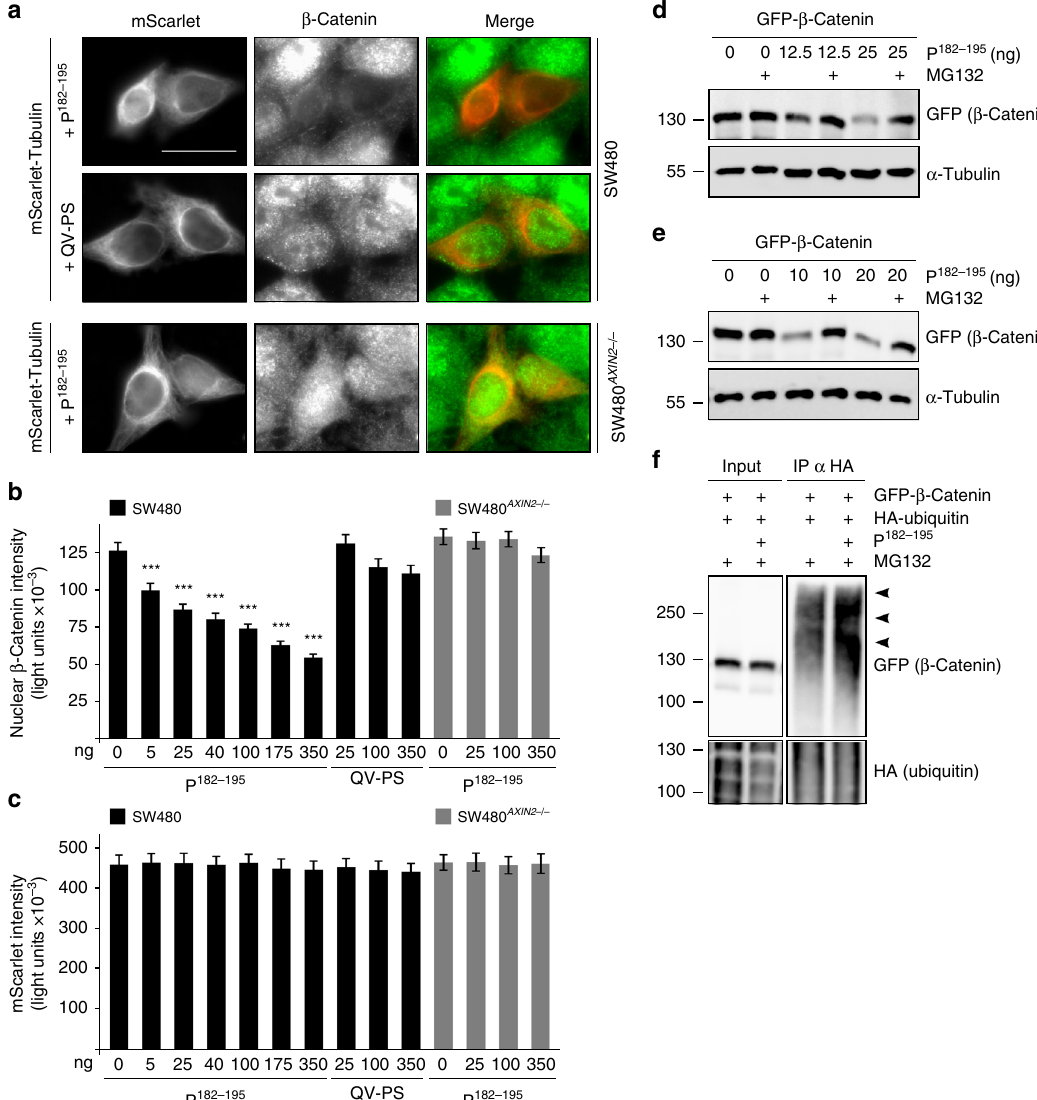
Fig. 6 P 182 – 195 induces proteasomal degradation of β -catenin. a Immuno fl uorescence staining of endogenous β -catenin (green) in SW480 and SW480 AXIN2 knockout cells co-transfected with P 182 – 195 or its QV-PS mutated analog together with mScarlet-tubulin (red) to visualize transfected cells. Scale bar: 20 µ m. b , c Quanti fi cation of nuclear β -catenin ( b ) or mScarlet ( c ) fl uorescence intensities in individual cells of four independent experiments as in a . Results are mean ± SEM ( n = 80); *** p < 0.001 (Student ’ s t -test). Da t a distribution is shown in Supplementary Fig. 10. d , e Western blotting for GFP and α -tubulin (loading control) in lysates of DLD1 ( d ) or HEK293T cells ( e ) transfected with indicated constructs, which were untreated or treated with the proteasome inhibitor MG132 (DLD1: 10 µ M for 6 h; HEK293T: 2.5 µ M for 2 h). Given nanograms (ng) of the peptide refer to the transfection of a 12 well. f Western blotting for GFP and HA in lysates (Input) of HEK293T cells transfected with indicated constructs, and after precipitation of HA-ubiquitin conjugated proteins from these lysates (IP α HA). Arrowheads point to polyubiquitinated GFP- β -catenin. HA blots show similar overall ubiquitination (Input) and similar precipitation of ubiquitinated proteins (IP) in both samples. Source data are provided as a Source Data fi